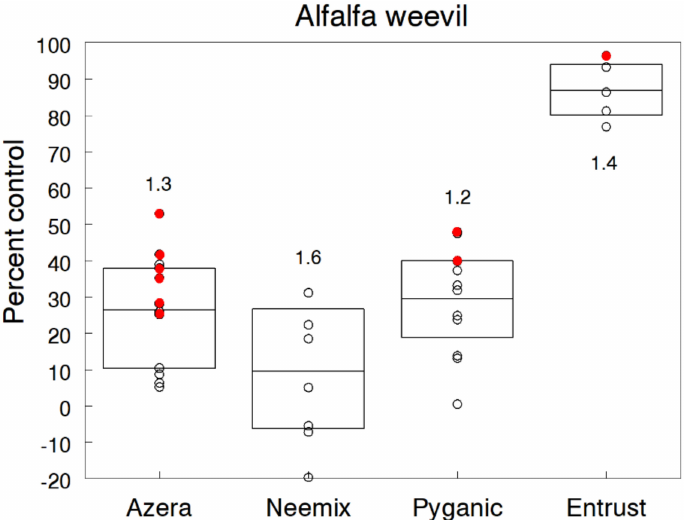
Figure 11. Percent control of alfalfa weevil with applications of Azera, Neemix, PyGanic and Entrust relative to the untreated control. Mean data are compiled from 10 trials on alfalfa. Box-whisker plots show the 25% and 75% percentile range of percent control data and the horizontal line in each box is the overall mean control e ffi cacy. Number associated with each plot indicates the average number of weekly applications. Application rates of Azera, Neemix, PyGanic and Entrust were 2.34 L / h, 1169 mL / h, 2.34 L / h and 71.2 g a.i. / h respectively, except for individual trial data in red indicating higher rates. Entrust provided significantly higher control compared to other